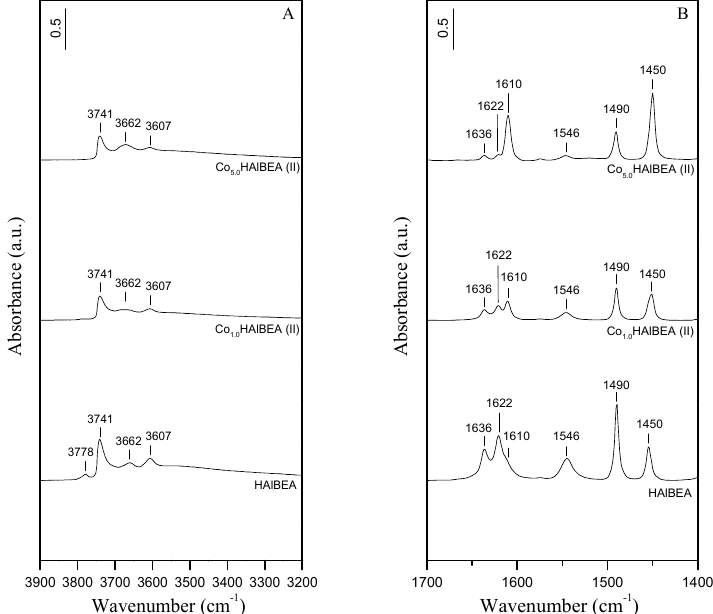
Figure 2. ( A ) FTIR spectra (vibration region of the OH groups) recorded at room temperature of HAlBEA, Co 1.0 HAlBEA(II), and Co 5.0 HAlBEA(II) and ( B ) FTIR difference spectra recorded at room temperature of HAlBEA, Co 1.0 HAlBEA(II), and Co 5.0 HAlBEA(II) after adsorption of pyridine (133 Pa) for 1 h at room temperature and desorption at 150 °C for 1 h.